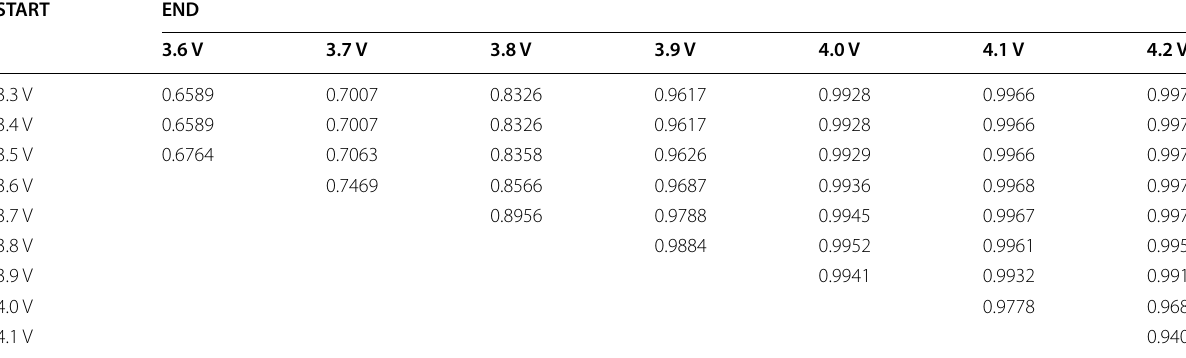
Table 2 Pearson correlation analysis between CEQ and LIB capacity with different voltage ranges START